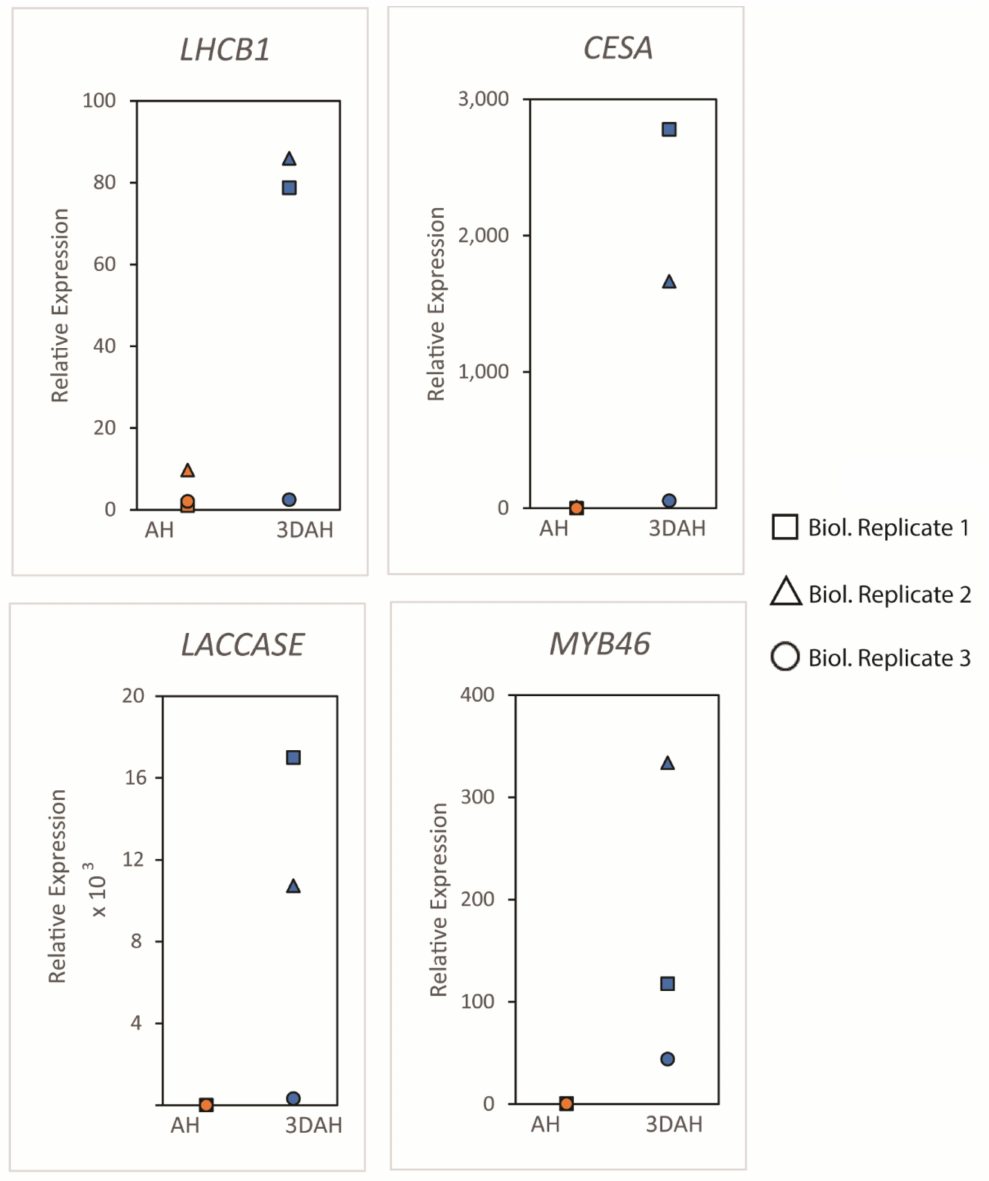
Figure 8. qRT-PCR analysis of LHCB1 , CESA , LACCASE and MYB46 on 3 biological replicates of yam tubers in Fonkouankem AH and 3DAH. Shapes represent each biological